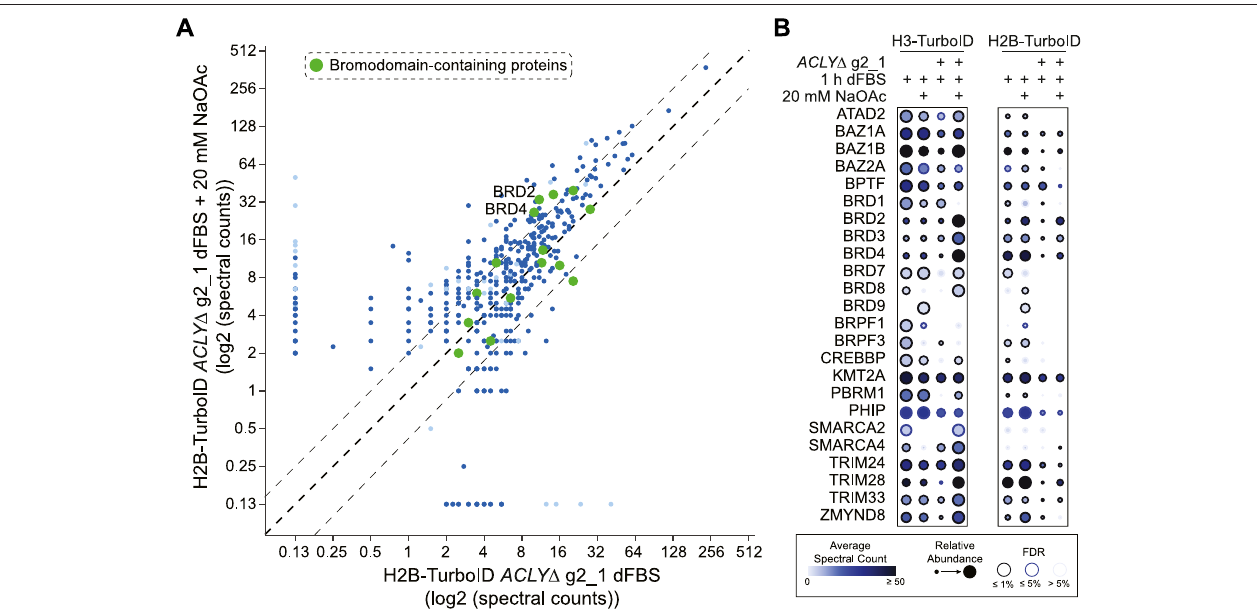
FIGURE 5 | Global chromatin rearrangements following Kac depletion. (A) Bait versus bait scatter plot of H2B-TurboID in HEK293 ACLY Δ g2_1 cells comparing dFBS treatments with and without 20 mM NaOAc. BRD-containing proteins are colored in green with signi fi cant proximity partners (FDR ≤ 1%) shown in dark blue and those with an FDR between 1 and 5% in light blue. The black dashed diagonal line indicates equal abundance for both conditions, with relative two-fold enrichment indicated by gray dashed lines on either side. (B) Dot plot of BRD-containing proteins identi fi ed as signi fi cant proximity partners (FDR ≤ 1%) of TurboID-tagged H3 and H2B in HEK293 ACLY Δ g2_1 cells treated with dFBS for 1 h with and without 20 mM NaOAc. See insert legend for